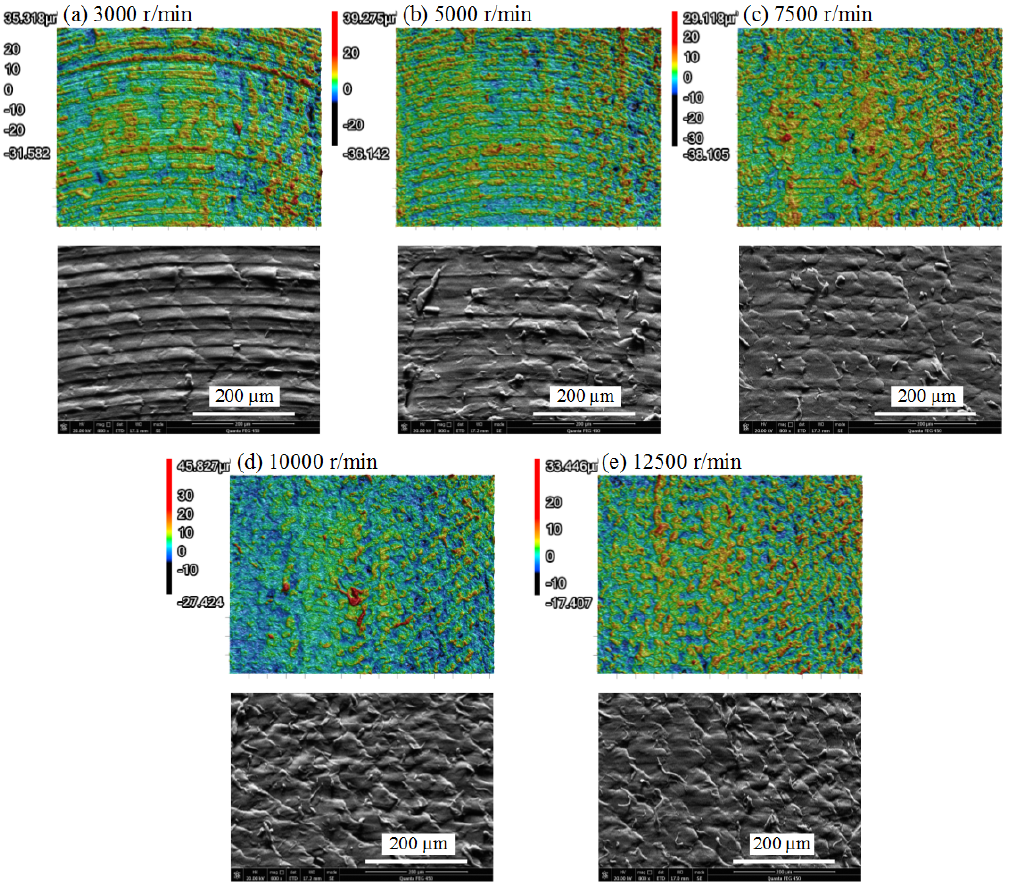
Figure 12. 3D morphologies and SEM pictures under different SSs (RA = 0 ° , LT = 0.1 mm, DOC = 0.2 mm, FRT = 0.02 mm): ( a ) SS = 3000r/min; ( b ) SS = 5000r/min; ( c ) SS = 7500r/min; ( d ) SS = 10000r/min; ( e ) SS = 12,500 r/min.